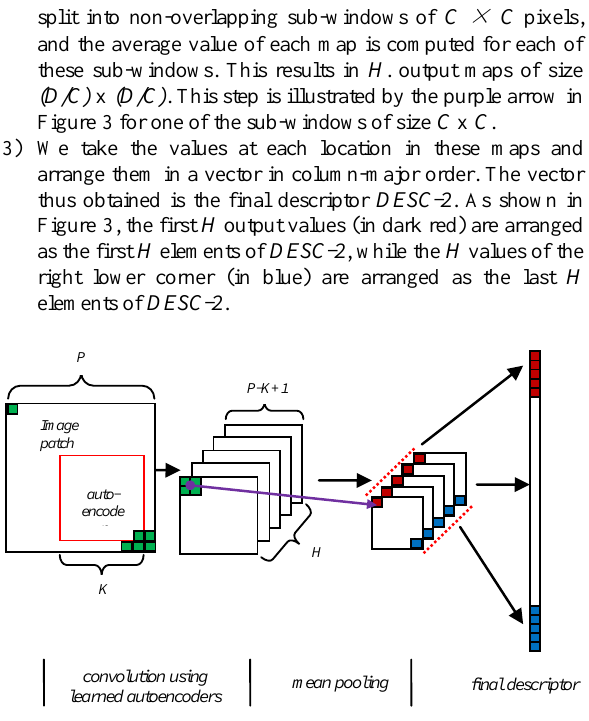
Figure 3. The procedure of building